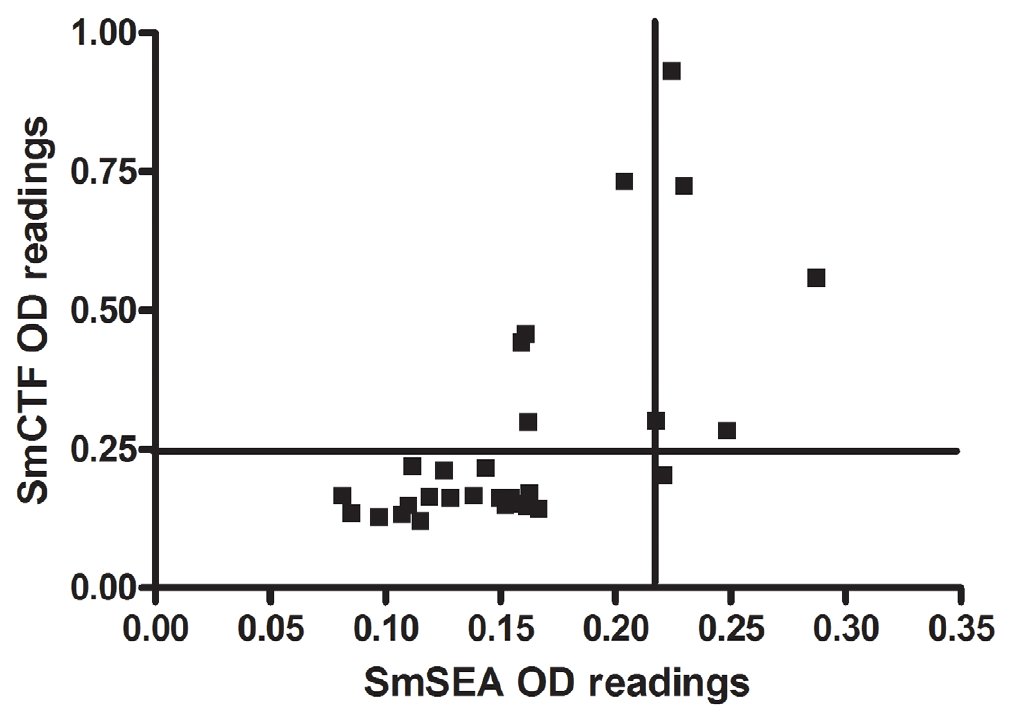
Figure 2. SPDRL: correlation between S.mansoni cercarial transformation fluid (SmCTF) and soluble egg antigen (SmSEA) in ELISA. Results for sera from those subjects in Figure 1 that had anti-SmSEA OD450 values of between 0 and 0.3. Vertical and horizontal lines indicate the cut- off values of, respectively, 0.22 for SmSEA and 0.25 for SmCTF.